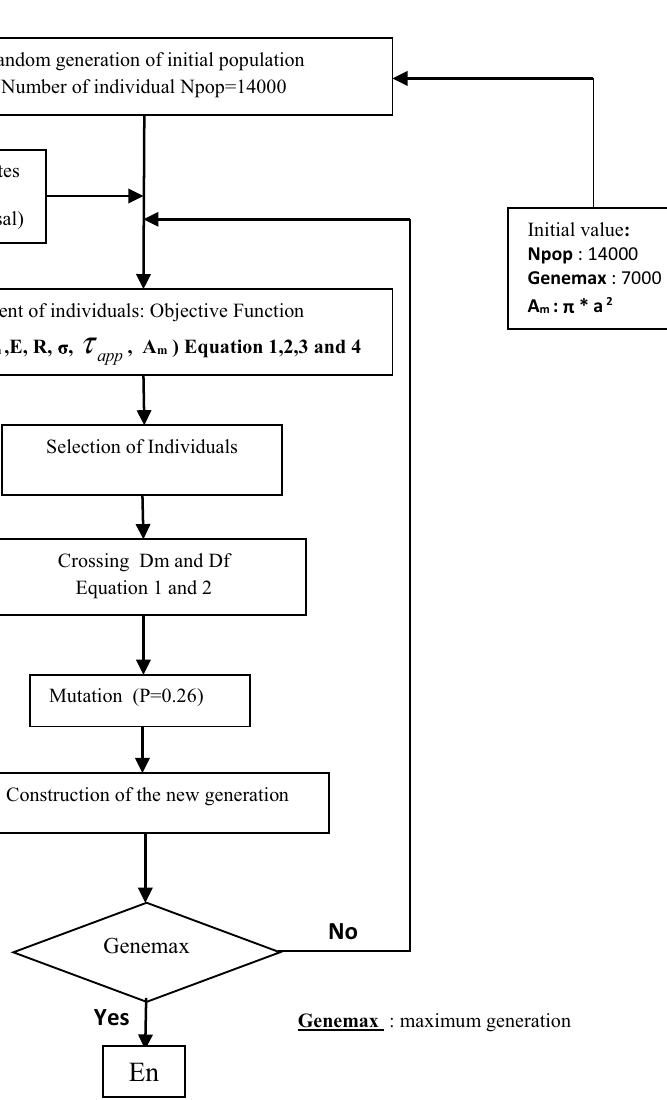
Fig. 2 The flowchart of genetic program